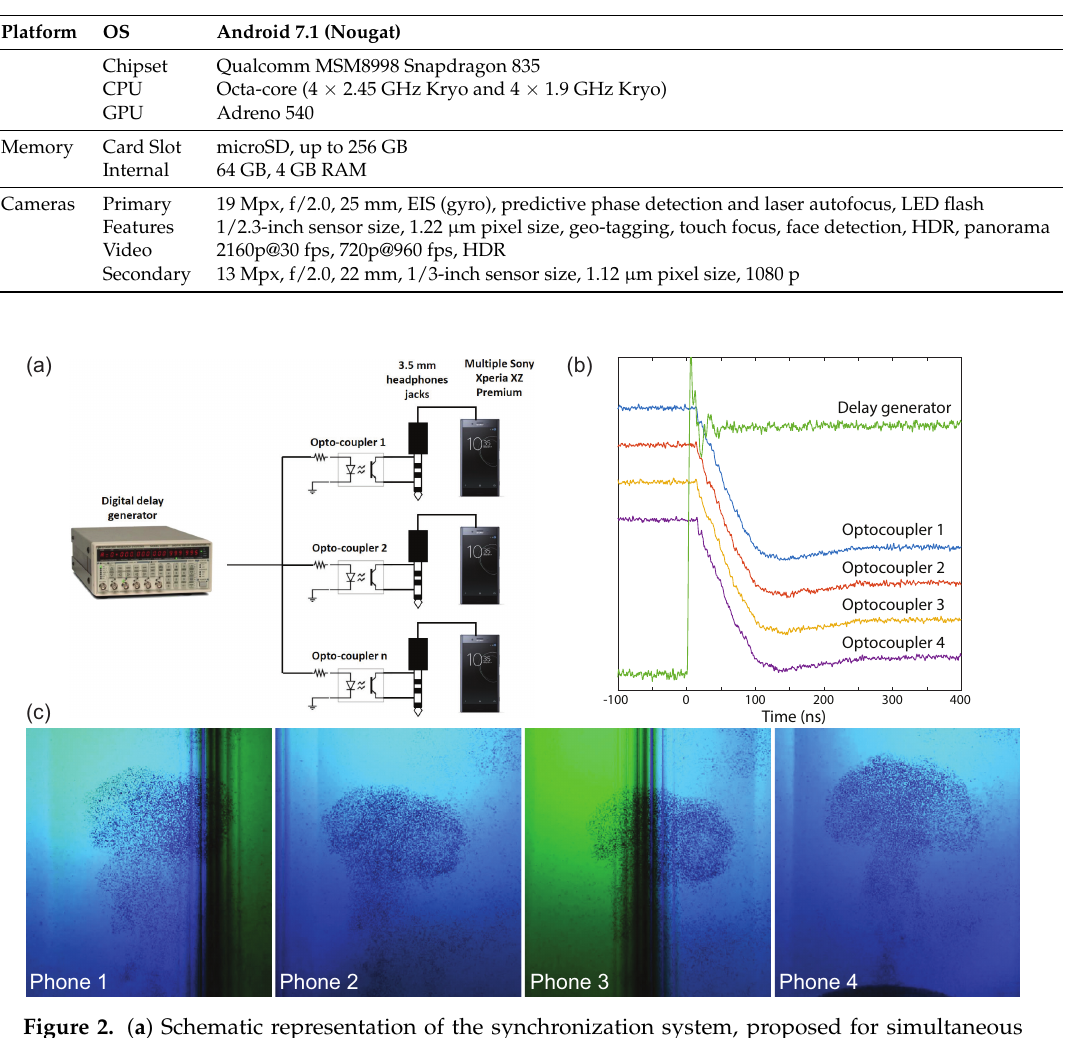
Table 1. Summary of relevant specifications of the Sony Xperia TM XZ premium smartphone [34].